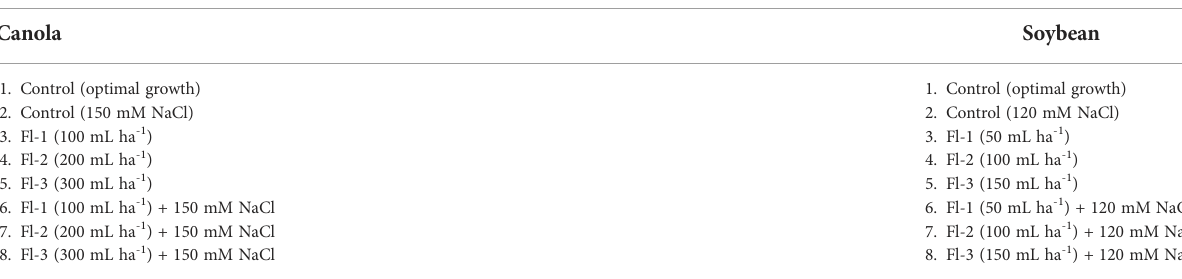
TABLE 1 Treatments – Foliar application of fl avonoids on canola and